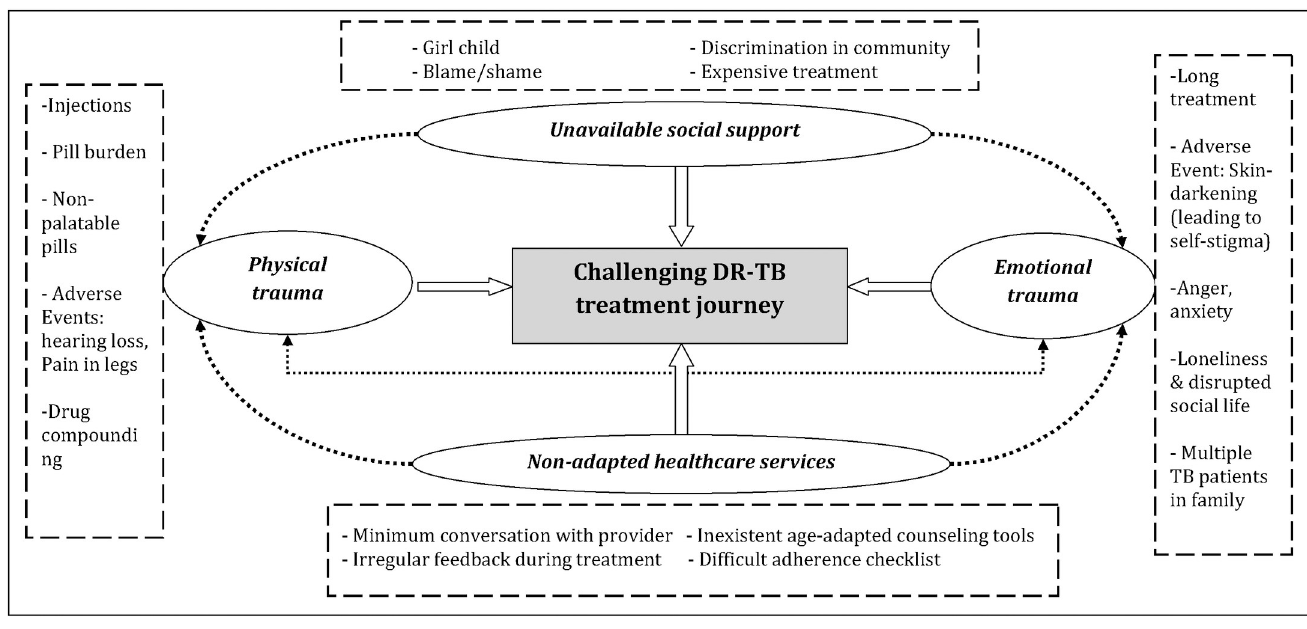
Fig 1. Non-hierarchical thematic network for ‘challenging DR-TB treatment journey’ in children and adolescents, Mumbai, India, 2019.